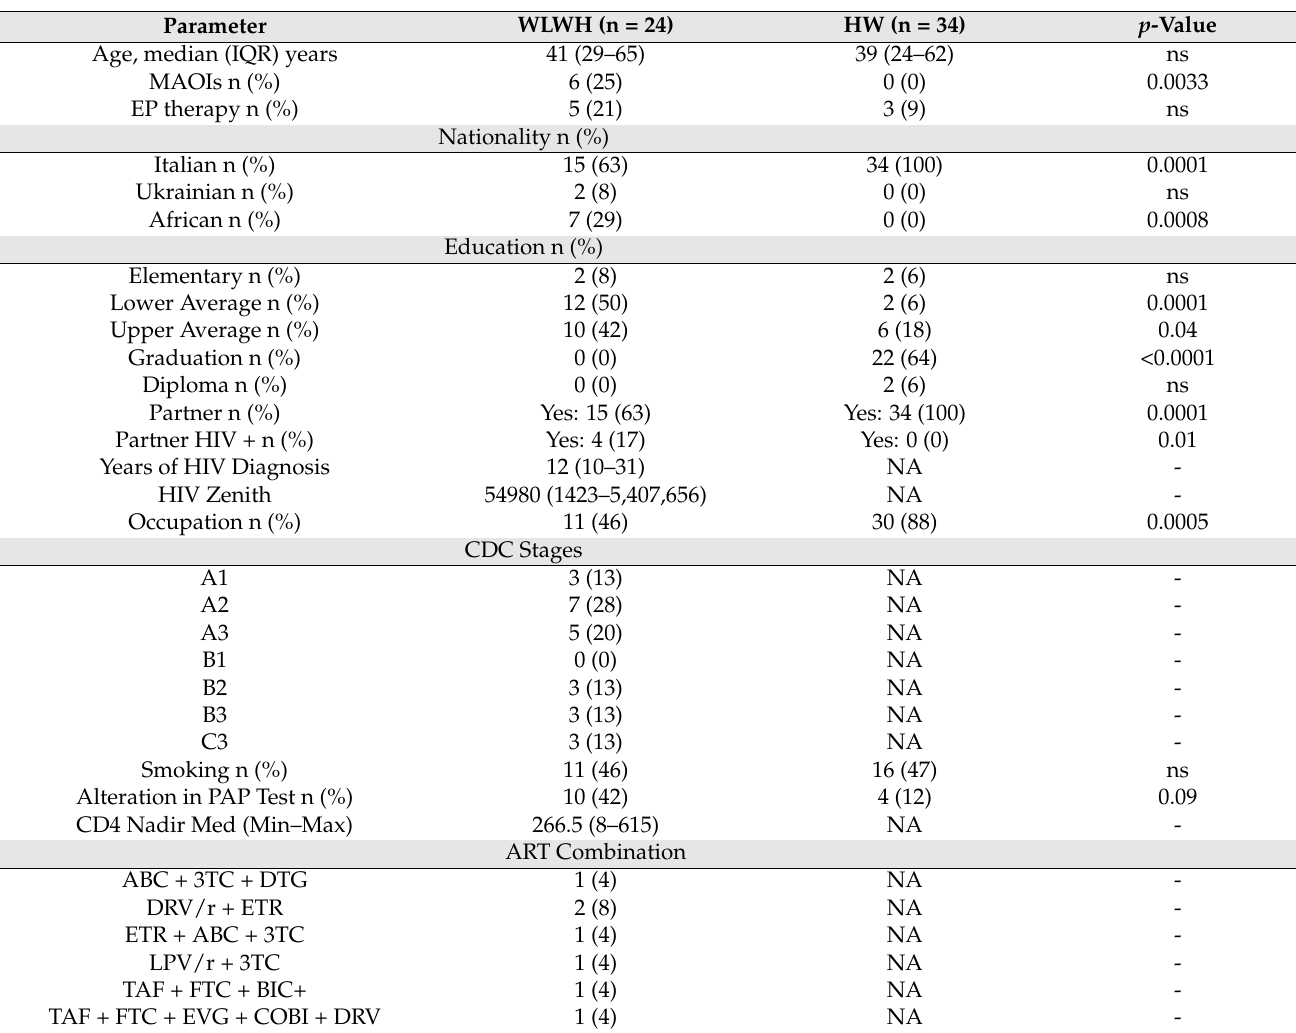
Table 1. Baseline clinical and demographic characteristics of